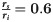
Wall shear stress for a case with blood recirculation (rsri=0.6).